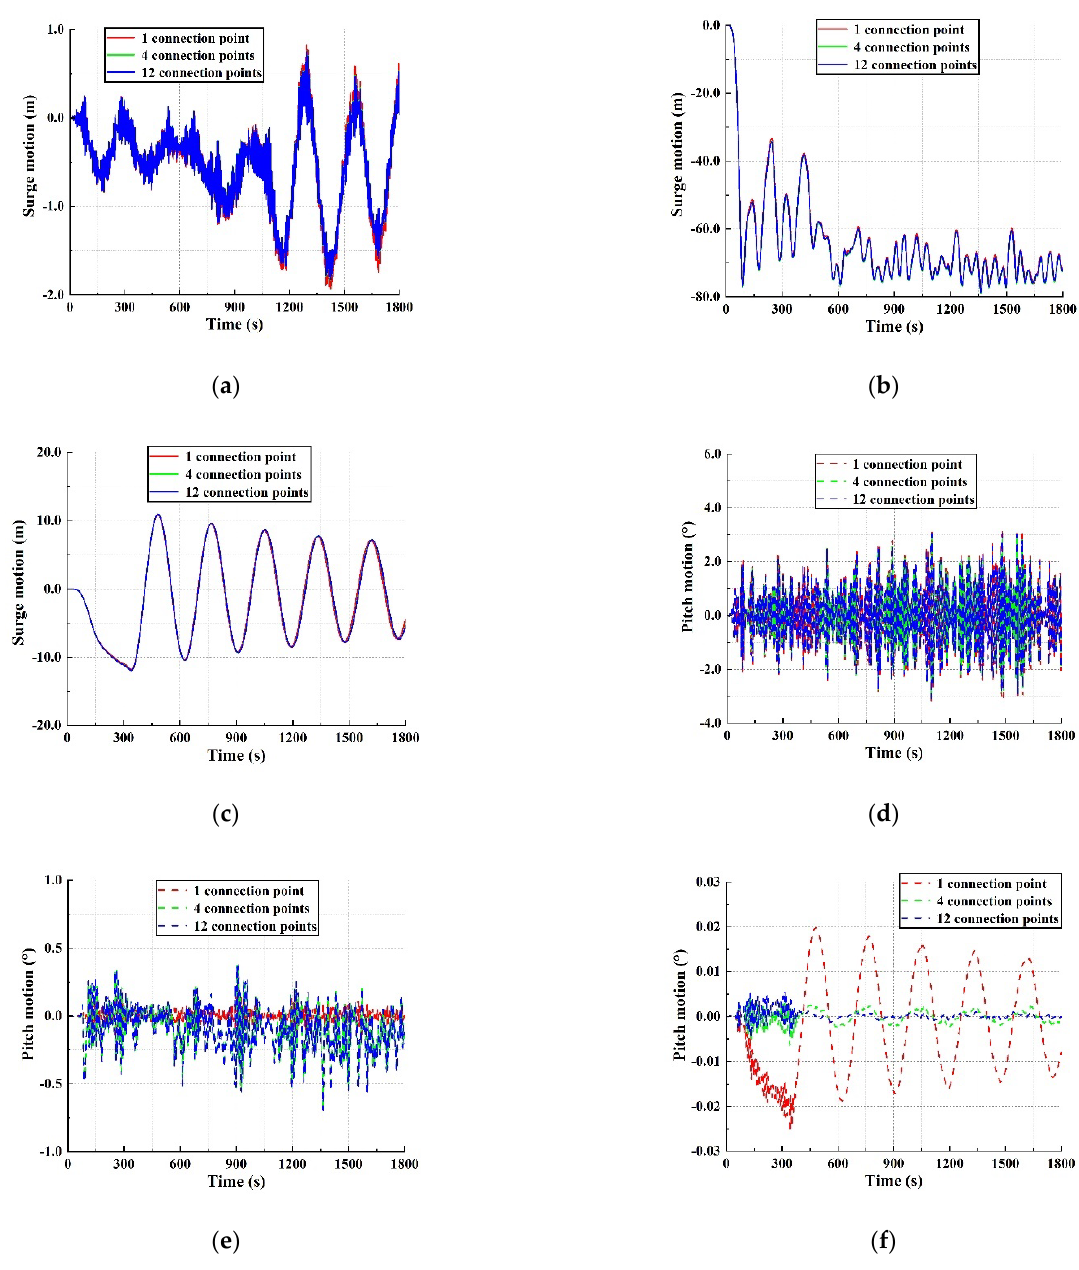
Figure 20. Influence of the number of connection points on Kulluk platform motion. ( a ) Surge motion under wave loads; ( b ) surge motion under level ice loads; ( c ) surge motion under broken ice floes loads; ( d ) pitch motion under wave loads; ( e ) pitch motion under level ice loads; ( f ) pitch motion under broken ice floes loads.